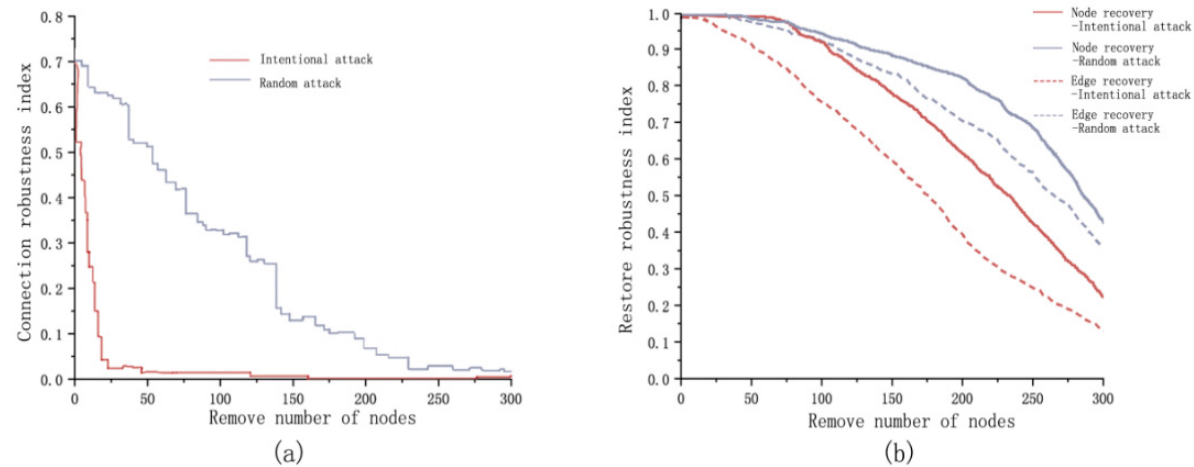
Figure 7. Ecological network robustness analysis before optimization: ( a ) connection robustness analysis of ecological network; ( b ) recovery robustness analysis of ecological network.